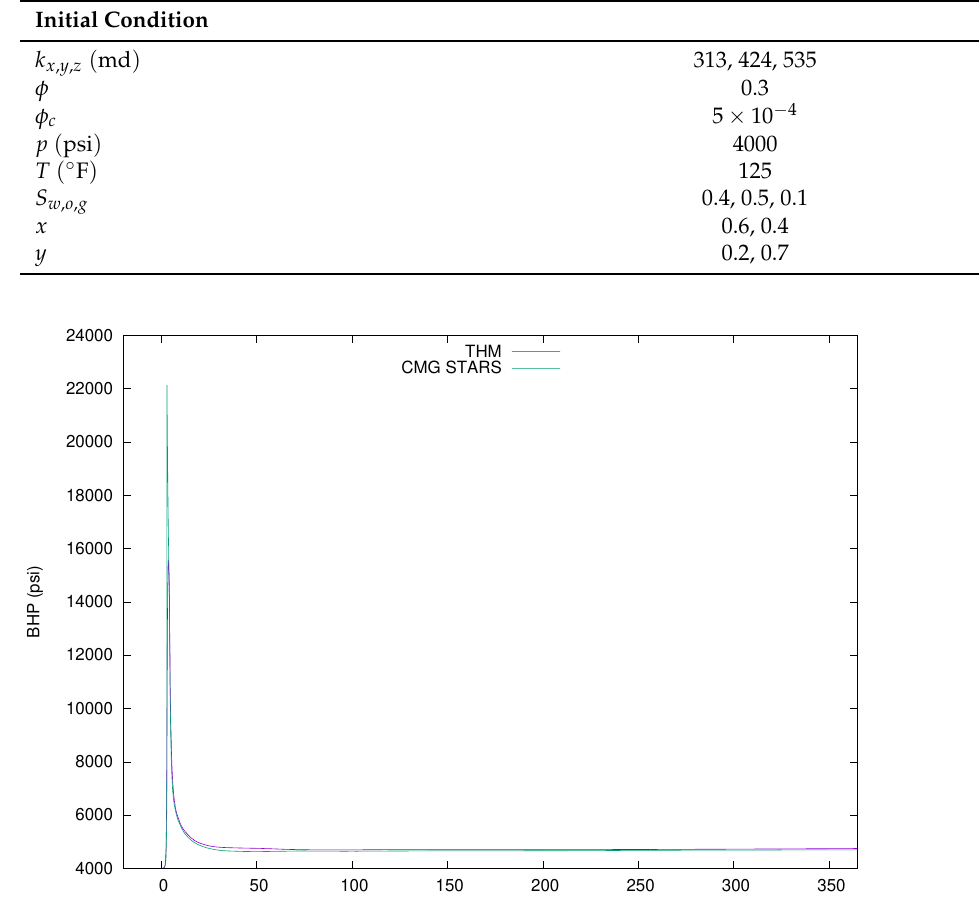
Figure 9. Example 2: injection well, bottom hole pressure (psi).